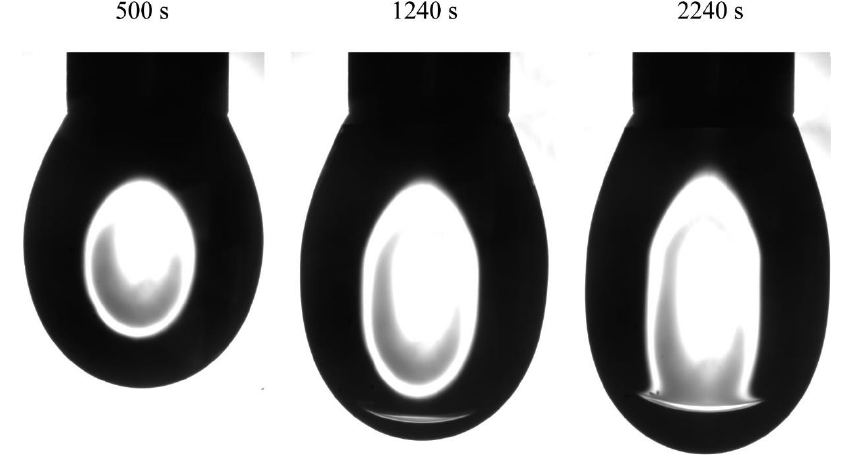
Figure 10. The images of С 14 ЕО 8 solution drop in hexane vapor obtained in the experiments with capillary diameter 2 mm, initial drop volume 20 mm 3 , solution concentration 1 μmol/L at times shown in the Figure. Table 2. Results obtained using di ff erent methods to determine the volume of C 14 EO 8 solution drops. Time, s Experiment [16], mm 3 V cyl , mm 3 V curv [16], mm 3 Error [16], µ m 500 17.35 17.23 2500 18.39 4500 18.91 18.77